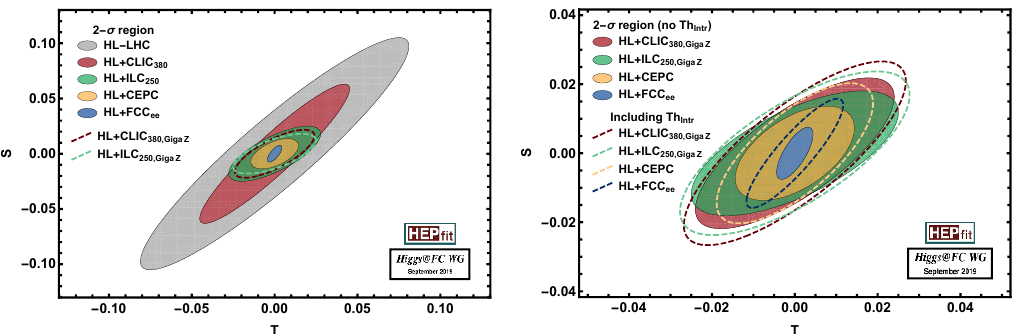
Figure 17 . (Left) 2- (cid:27) regions in the S (cid:0) T plane at the di(cid:11)erent future colliders, combined with the HL-LHC (including also the LEP/SLD EWPO programme). We express the results in terms of the usually normalised parameters: S = 4 sin 2 (cid:18) w ^ S=(cid:11) and T = ^ T=(cid:11) . The results include the future projected parametric uncertainties in the SM predictions of the di(cid:11)erent EWPO, but not the intrinsic ones. (Right) The same illustrating the impact of neglecting such intrinsic theory errors. For each project (including the Giga-Z option for linear colliders) the solid regions show the results in the left panel, to be compared with the regions bounded by the dashed lines, which include the full projected theory